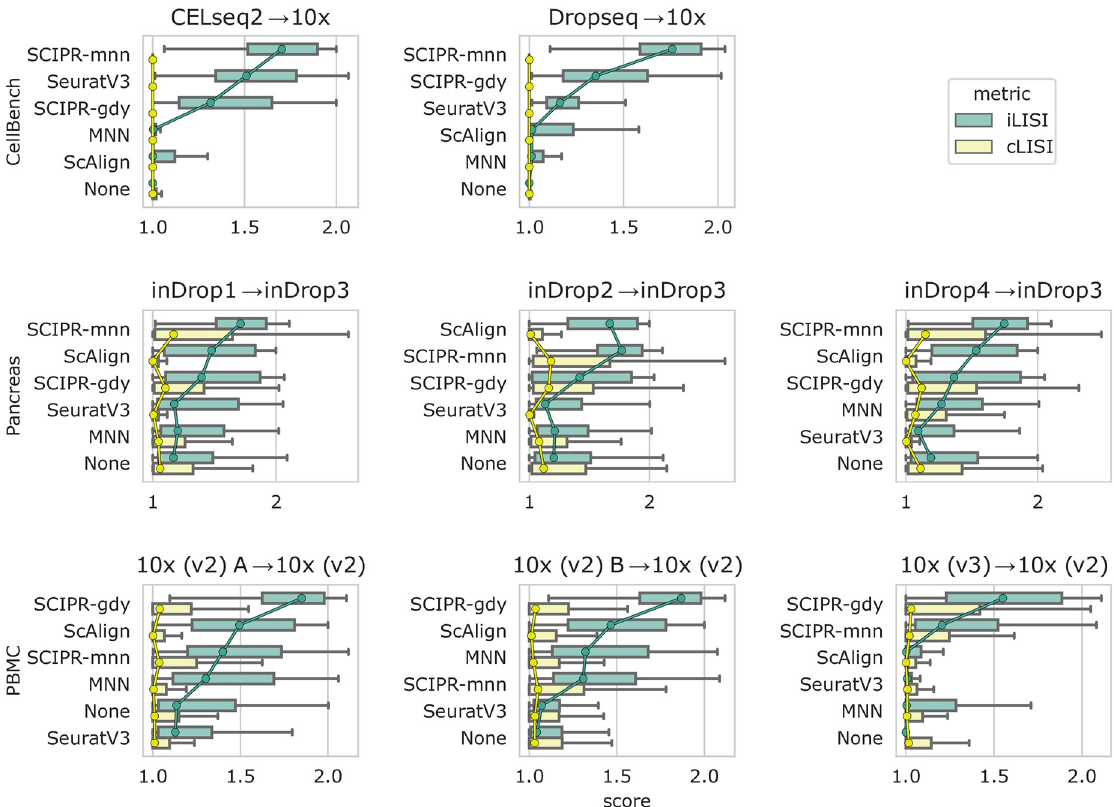
Fig 2. Quantitative scoring of alignment methods on benchmark datasets. Each row of subplots are tasks from the same dataset, where each column uses a different source batch (all are aligned to the same largest reference batch). The scores are iLISI (green, batch integration score), and cLISI (yellow, cell type mixing score). In each subplot the methods are ordered from top to bottom in order of largest difference (median iLISI − median cLISI) of scores. “None” means no alignment method is applied to the data. The center of each box is the median, and whiskers represent 1.5 times the IQR past the low and high quartiles. Circle markers are placed on the medians and connected between boxes with lines of the corresponding color to facilitate visual